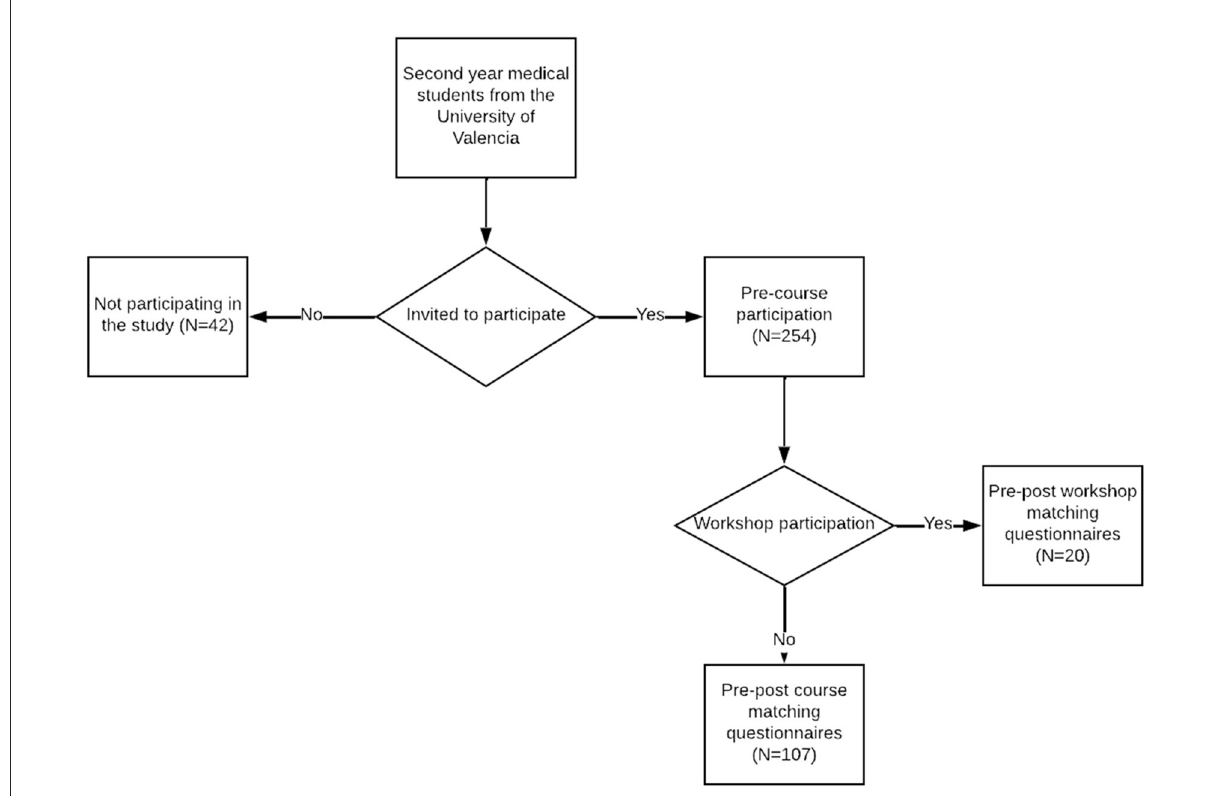
FIGURE1 Study flow